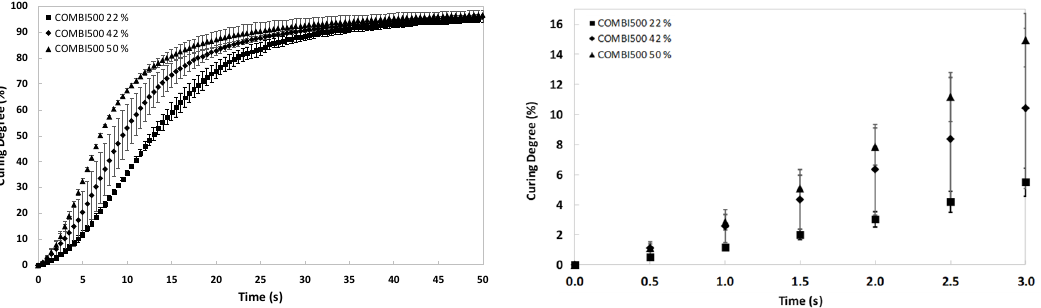
Figure 11. ( Left ) Curing degree of MAT450 with 20 ( ■ ), 29 ( ♦ ), and 47 wt.% ( ▲ ) fibre contents. ( Right ) Magnification from 0 to 3 s time of curing.